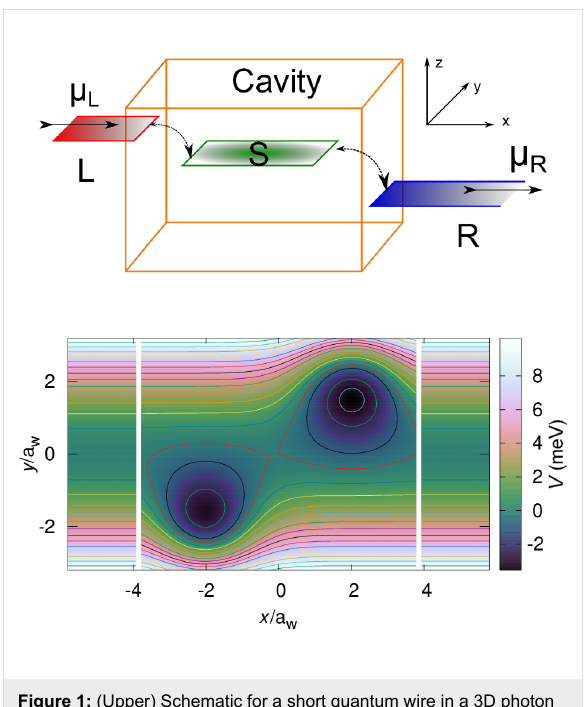
Figure 1: (Upper) Schematic for a short quantum wire in a 3D photon cavity coupled to semi-infinite external left (L) and right (R) leads with quasi 1D electron systems with chemical potentials μ L and μ R , respec- tively. The electrons in the short quantum wire and the photons of the cavity comprise the central system (S). (Lower) The potential energy landscape defining the two asymmetrical quantum dots embedded in a short quantum wire of length L x = 180 nm ≈ 7.6 a w , where a w = 23.8 nm is the effective magnetic length for transverse magnetic field B ext = 0.1 T and parabolic confinement energy = 2.0 meV of the short wire and leads in the y -direction. The white gaps at x ≈ ±3.8 a w indicate the onset of the semi-infinite leads. The right dot is slightly deeper and broader than the left dot.